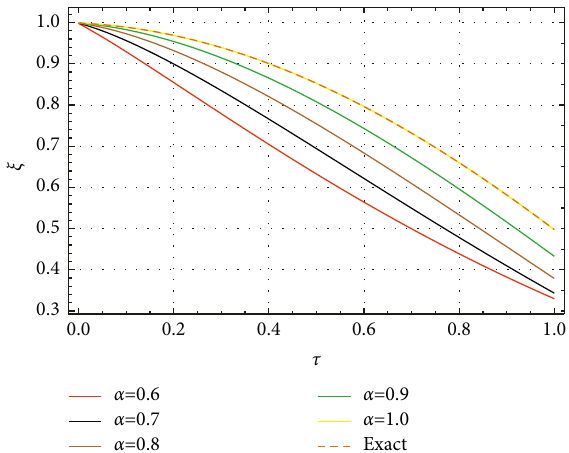
Figure 1: The approximate and exact solutions to the real part of Example 1.